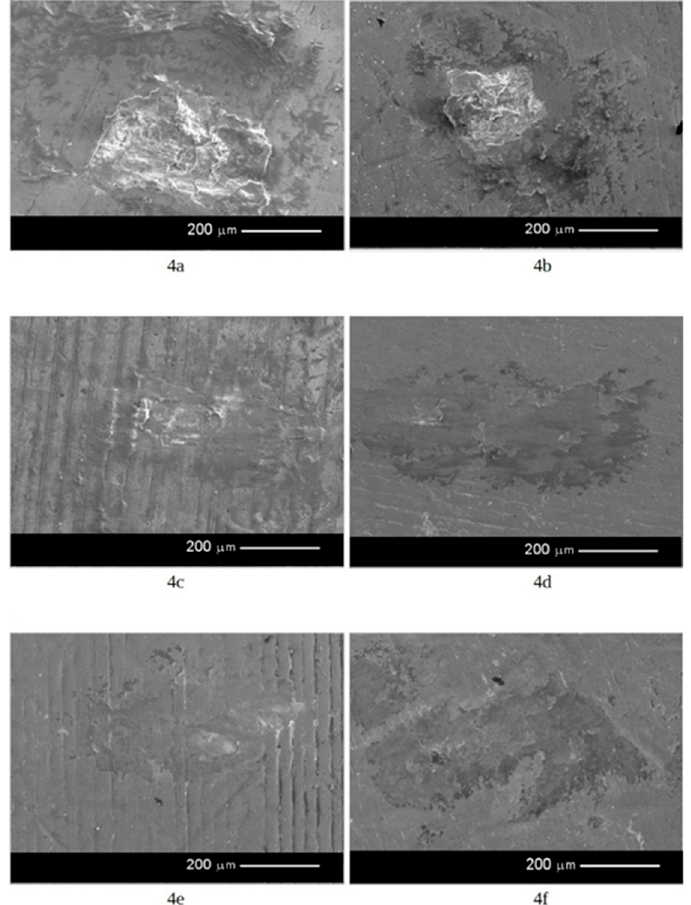
Figure 4. Microscopic images of the wear areas for sample S1 with the following test parameters: ( a ) 5 N / 15 min; ( b ) 10 N / 15 min; ( c ) 15 N / 15 min; ( d ) 15 N / 30 min; ( e ) 15 N / 60 min; ( f ) 15 N / 120 min.